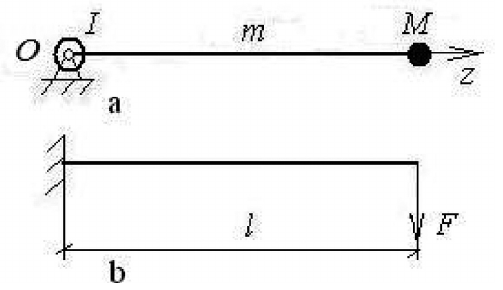
Fig. 2. (a) Bow-and-rod schematic model; (b) cantilever beam loaded at the free end with a concentrated force F